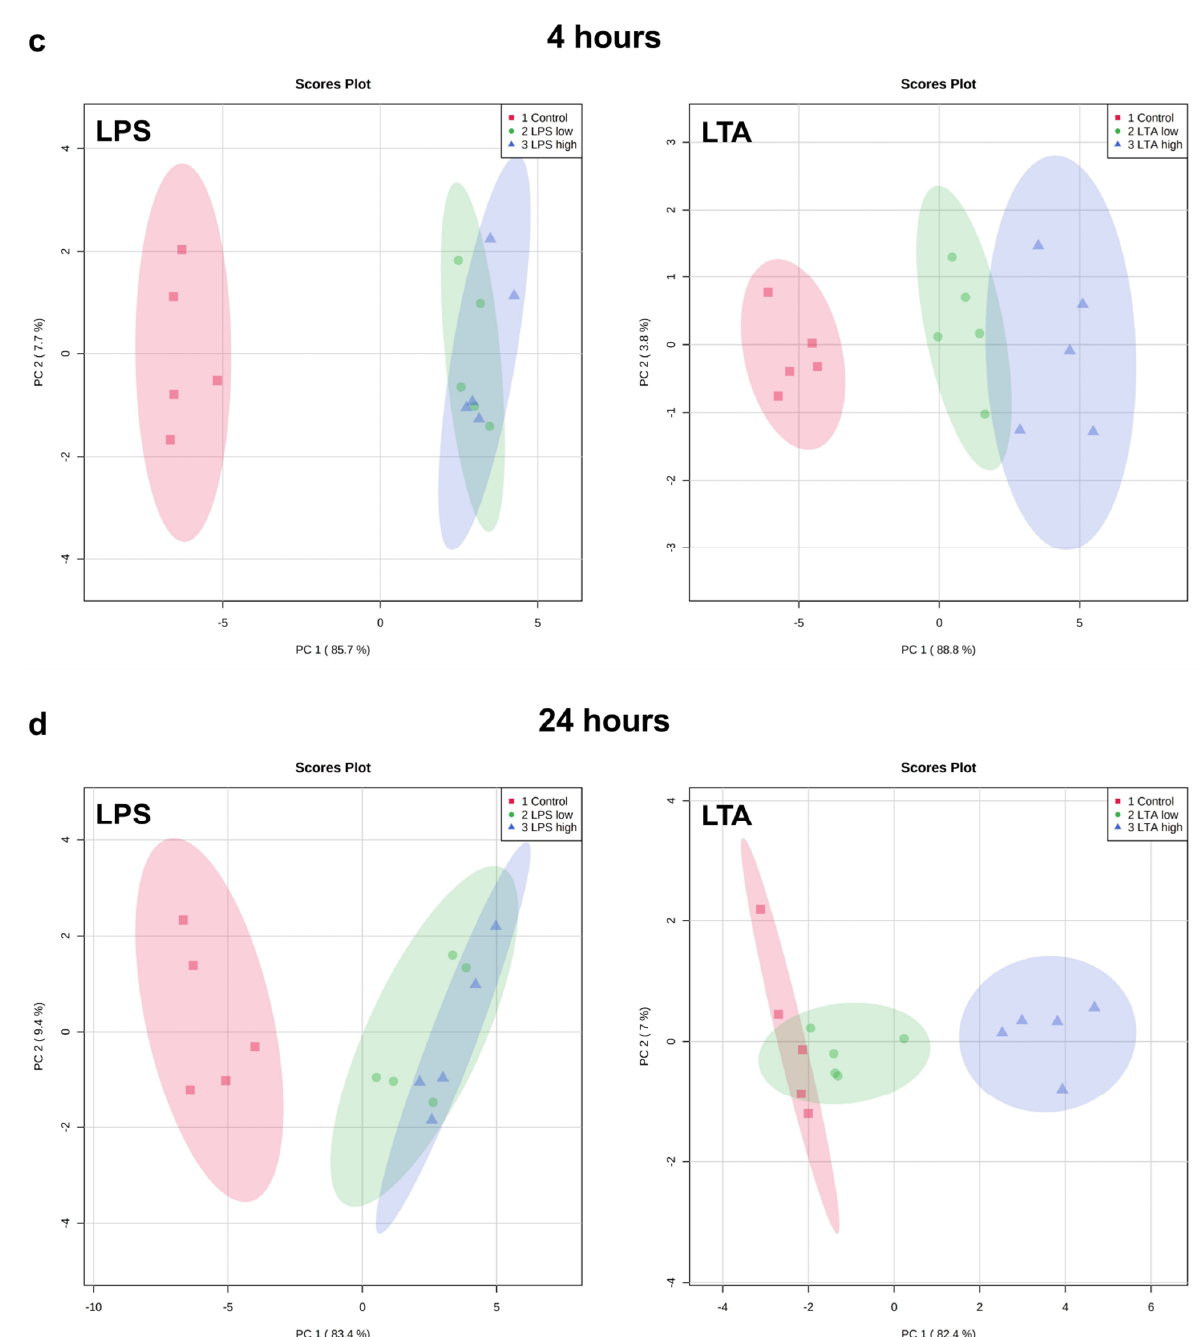
Figure 3. PCA plots of the expression of all measured genes of RECs treated with medium only (control), LPS low (1 µ g/mL), LPS high (10 µ g/mL), LTA low (1 µ g/mL), and LTA high (10 µ g/mL) for 1 ( a ), 2 ( b ), 4 ( c ), and 24 ( d ) h. n = 5 independent experiments.